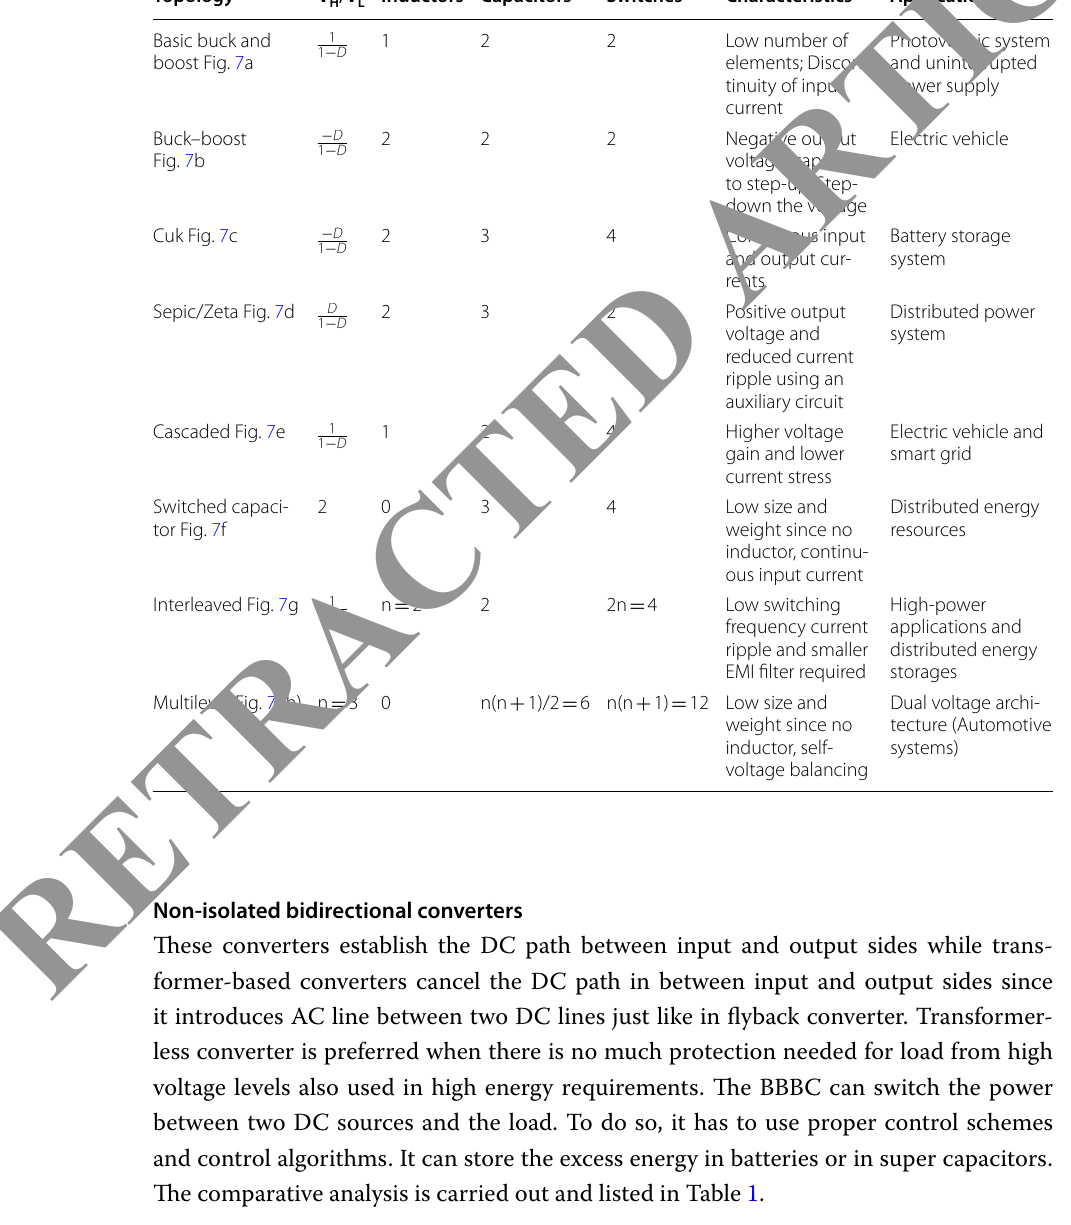
Table 1 Assessment of non-isolated bidirectional DC-DC converters Topology Characteristics Basic buck and boost Fig. 7a